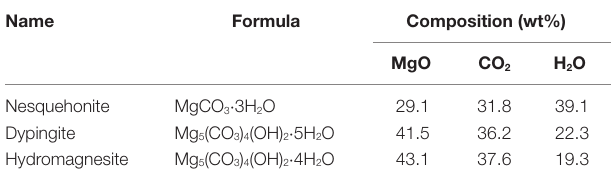
TaBle 1 | commonly synthesized Mhch phases.